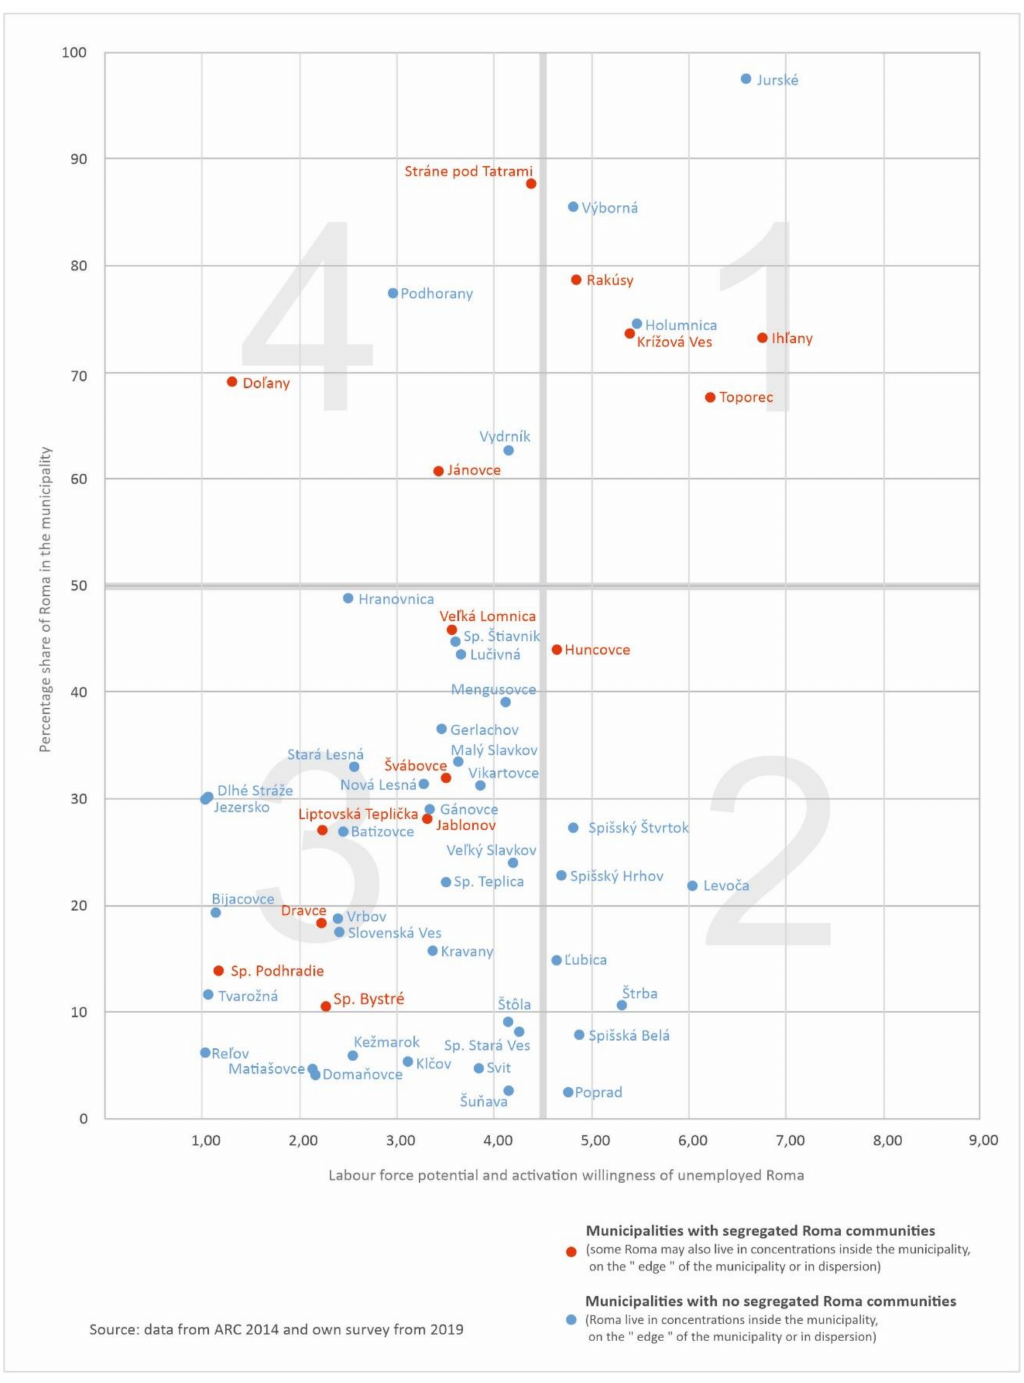
Figure 3. Labour force potential and activation of the unemployed Roma (The Activation Works pro- gram) in the MRCs of Central Spiš. Source: own evaluation based [45,47] for more see methodology. Social Work (SW) is provided within the framework of the National Project Social